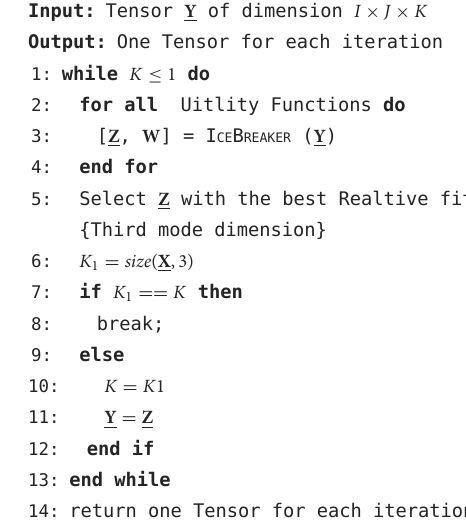
Algorithm 2. I CE B REAKER ++